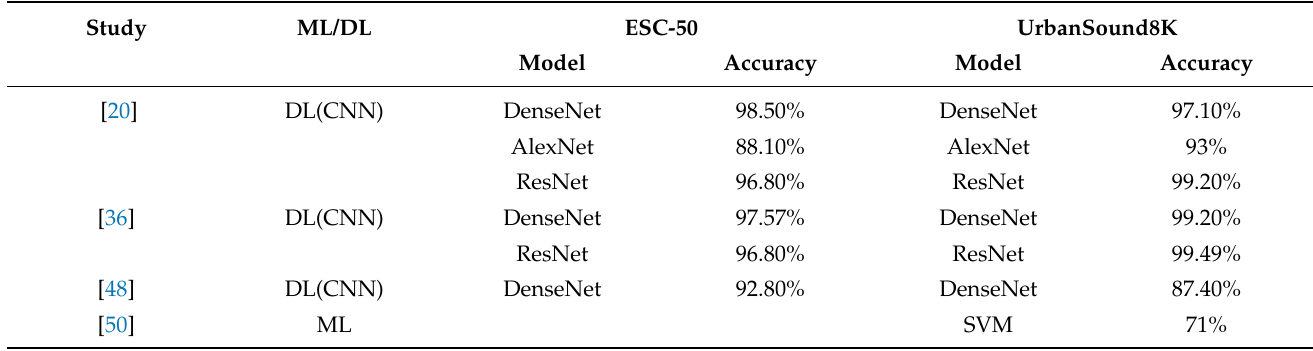
Table 2. Related studies on sound classification using ESC-50 and UrbanSound8K Dataset.